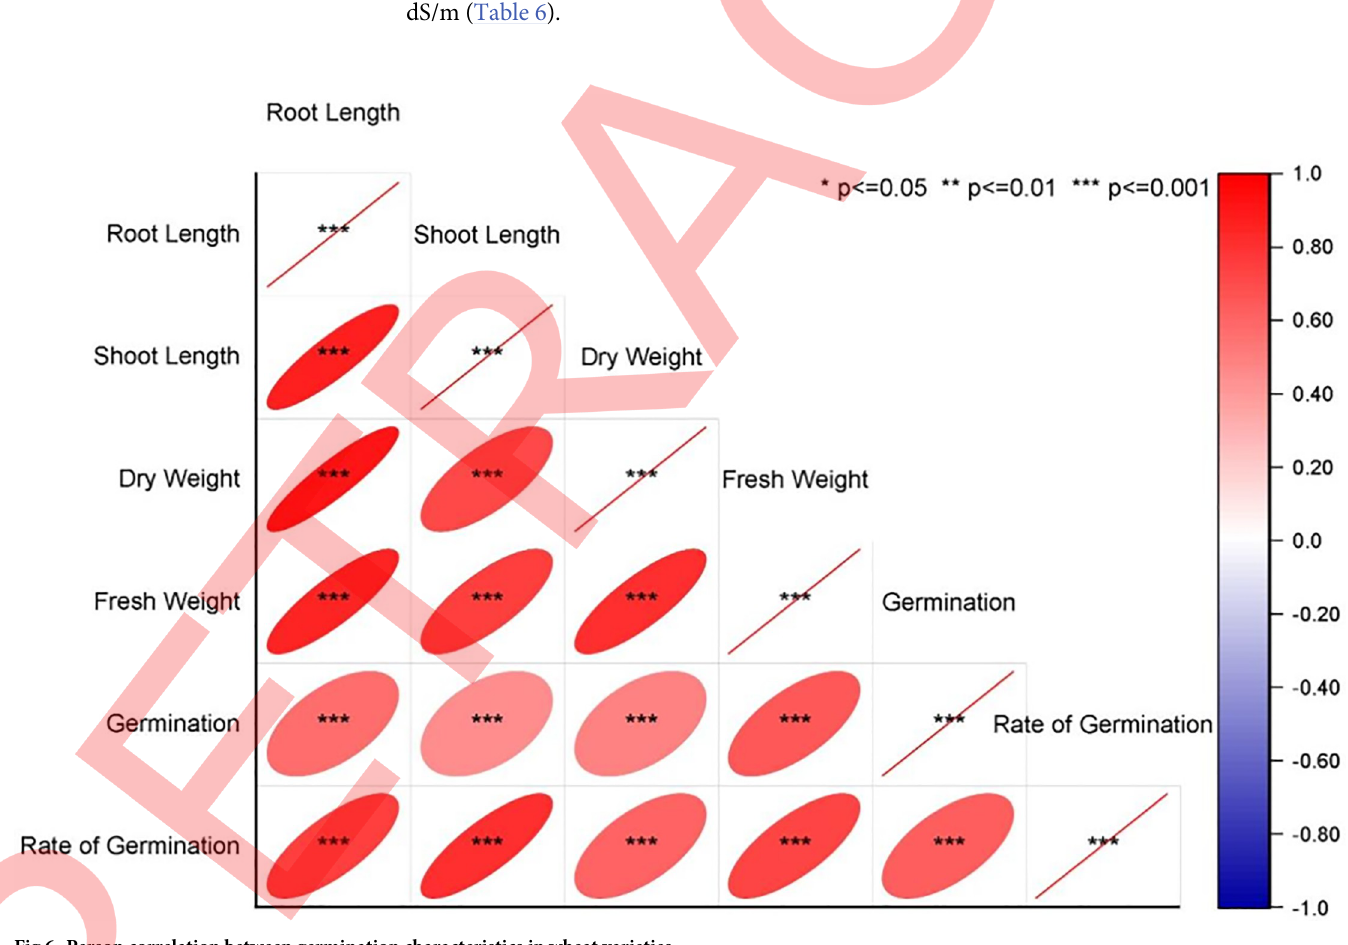
‘Rakhshan’ also different significantly better over Sirvan’ and ‘Heidari’ at 8 and 12 dS/m. No significant change was noted in FWSI among all the varie- ties at 4 dS/m. Rakhshan’, ‘Heidari’ and ‘Sirvan’ were significantly higher in FWSI at 8 and 12 dS/m (Table 6).